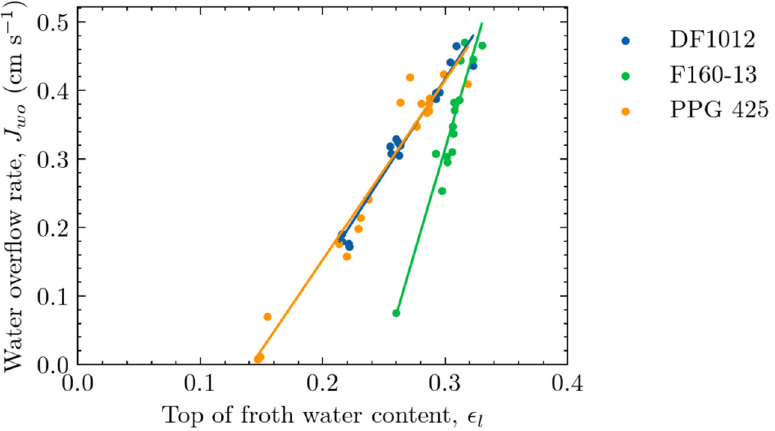
Figure 13. Comparison of the relationship of water overflow rate and froth water content for the frothers tested at an air velocity of 2.0 cm s − 1 .